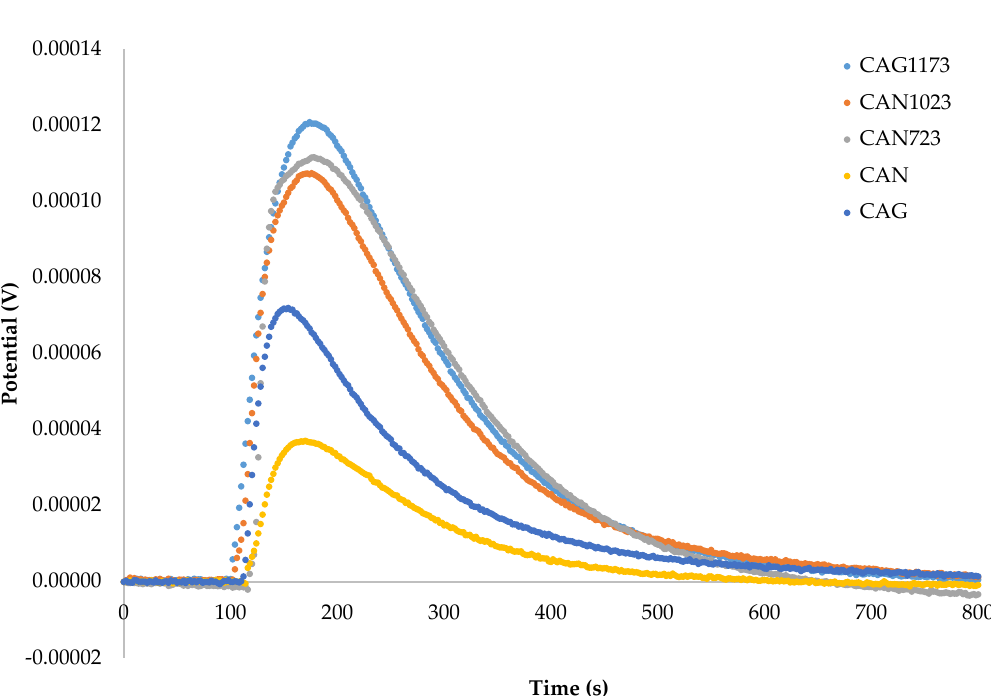
Figure 3. Curves of electric potential as a function of the immersion time of activated carbons in hexane.